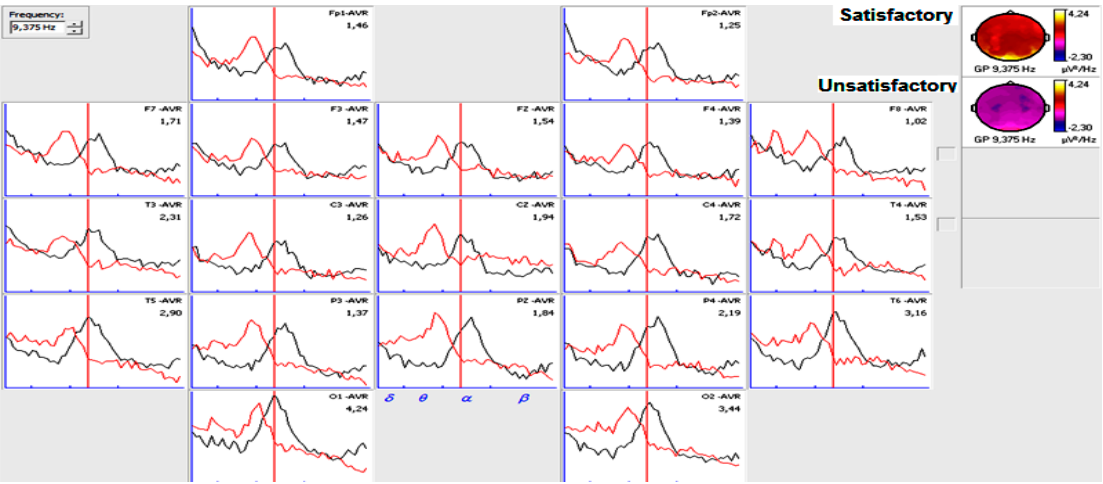
Figure 5. Band quantitative analysis in patients six months after surgery with epilepsy in the left temporal lobe and different evolution in the second year.Black spectrum (Frequency composition of a patient six months after surgery and satisfactory post-surgical evolution in the second year).Red spectrum (Frequency composition of a patient six months after surgery and unsatisfactory post-surgical evolution in the second year).